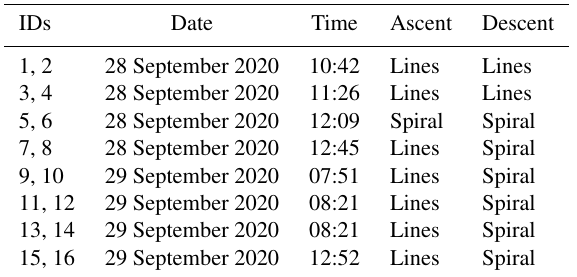
Table 3. A table detailing the profile types of the UAV flights con- sidered for analysis. The profile IDs are shown for the ascending and descending profiles,